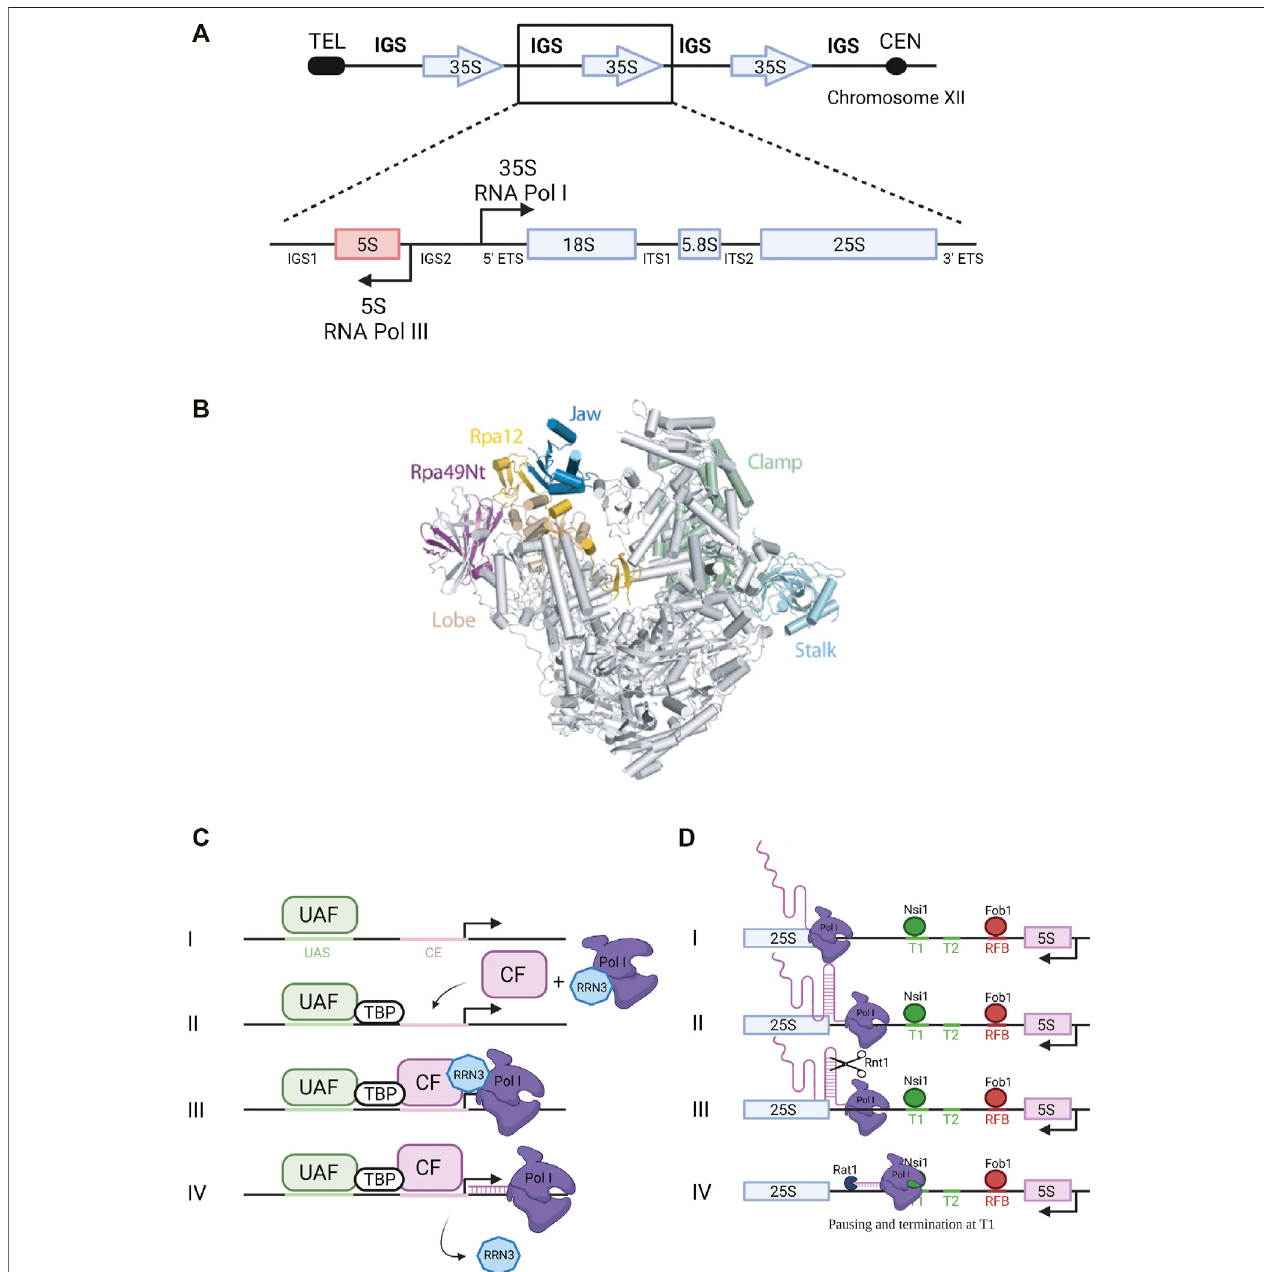
FIGURE1| RibosomalDNAtranscriptionbyRNAPolI. (A) RibosomalDNA.TherDNArepeats(150 – 200copies)arelocatedonchromosomeXII.Asinglerepeated unit is transcribed by RNA polymerase I (Pol I) to synthesize the 35S primary pre-rRNA transcript, which is then processed to produce the mature 18S, 5.8S and 25S rRNAs (arrow pointing to the right). RNA Polymerase III synthesizes the 5S rRNA (arrow pointing to the left). IGS, intergenic sequence; ETS, external transcribed spacer; ITS, internaltranscribedspacer. (B) RNAPolymeraseI.PolI3Dstructure(Darrièreet al.,2019).Viewoftheinitiallytranscribingcomplexmodel and its fourdifferent subunits-PDB5W66(Hanetal., 2017).Catalytic aminoacidsarelocated inthecenterofthecentralcleft.Thetwomainmodulesaremobileand allowcleftopeningand closure,dependingofthetranscriptionstep. (C) Transcriptioninitiation.CompositionofPolIpre-initiationcomplex( see textfordetails).UAF,UpstreamActivatingFactor; TBP, TATA-binding protein; CF, Core Factor. (D) Transcription termination. Pol I termination mechanisms ( see text for details).